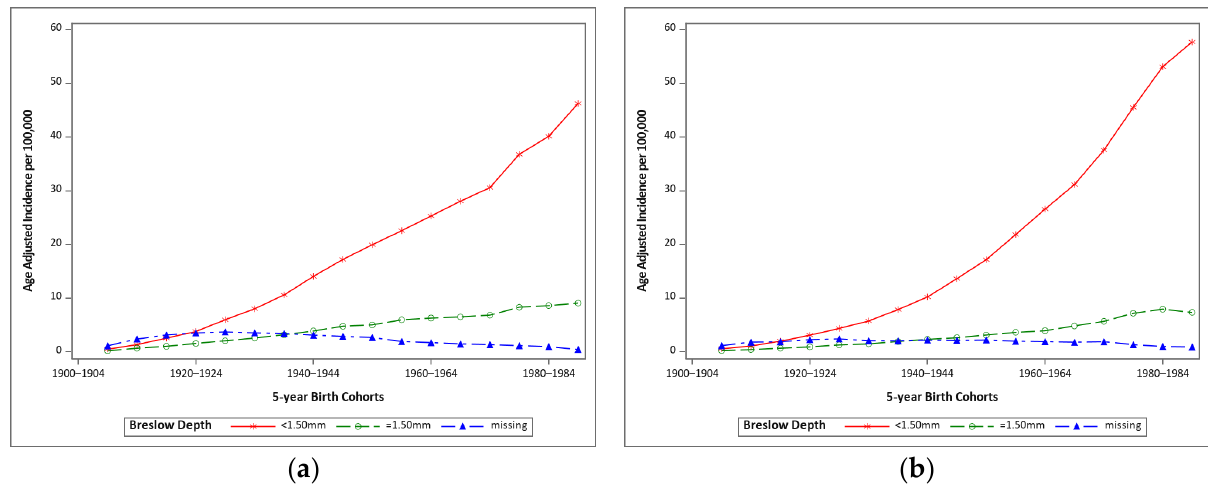
Figure 2. Age-adjusted incidence of malignant melanoma for 5-year birth cohorts by Breslow depth category for ( a ) males and ( b ) females. Data from SEER 9, 1975–2017.